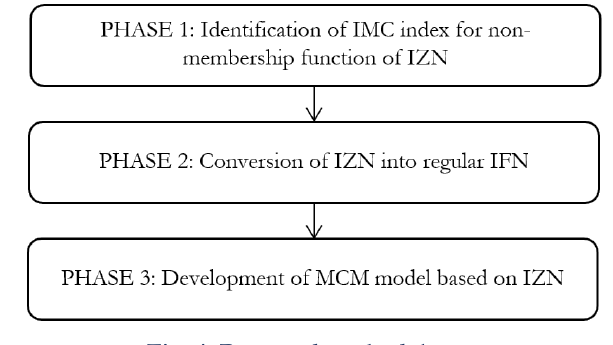
Fig. 4. Proposed methodology.